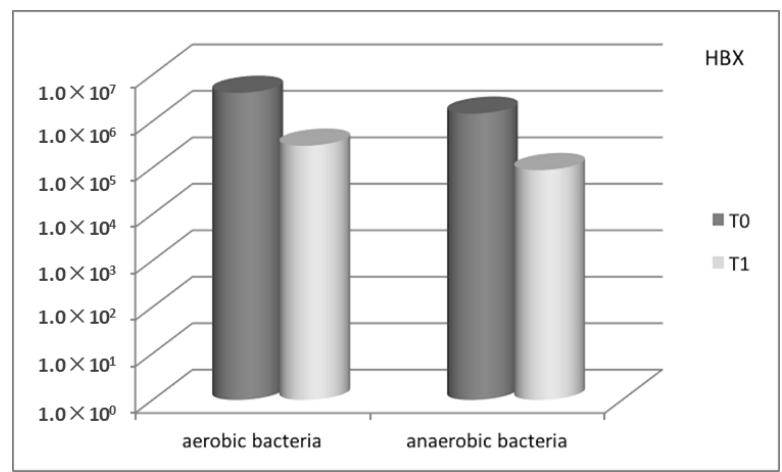
Figure 2. Total microbial count for Test-Group (HBX) between baseline (T0) and three-month follow-up (T1), for aerobic and anaerobic bacteria,